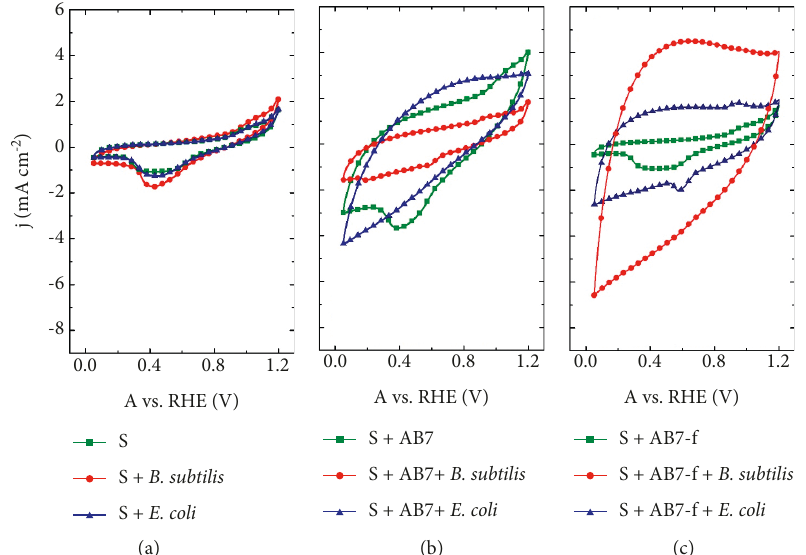
Figure 5: Half-cell characterization of the bioanodes with different configurations using N 20mVs − 1 and as support (S) carbon cloth, (a) S +bacteria, (b) S +AB7 +bacteria, and (c) S +AB7-f